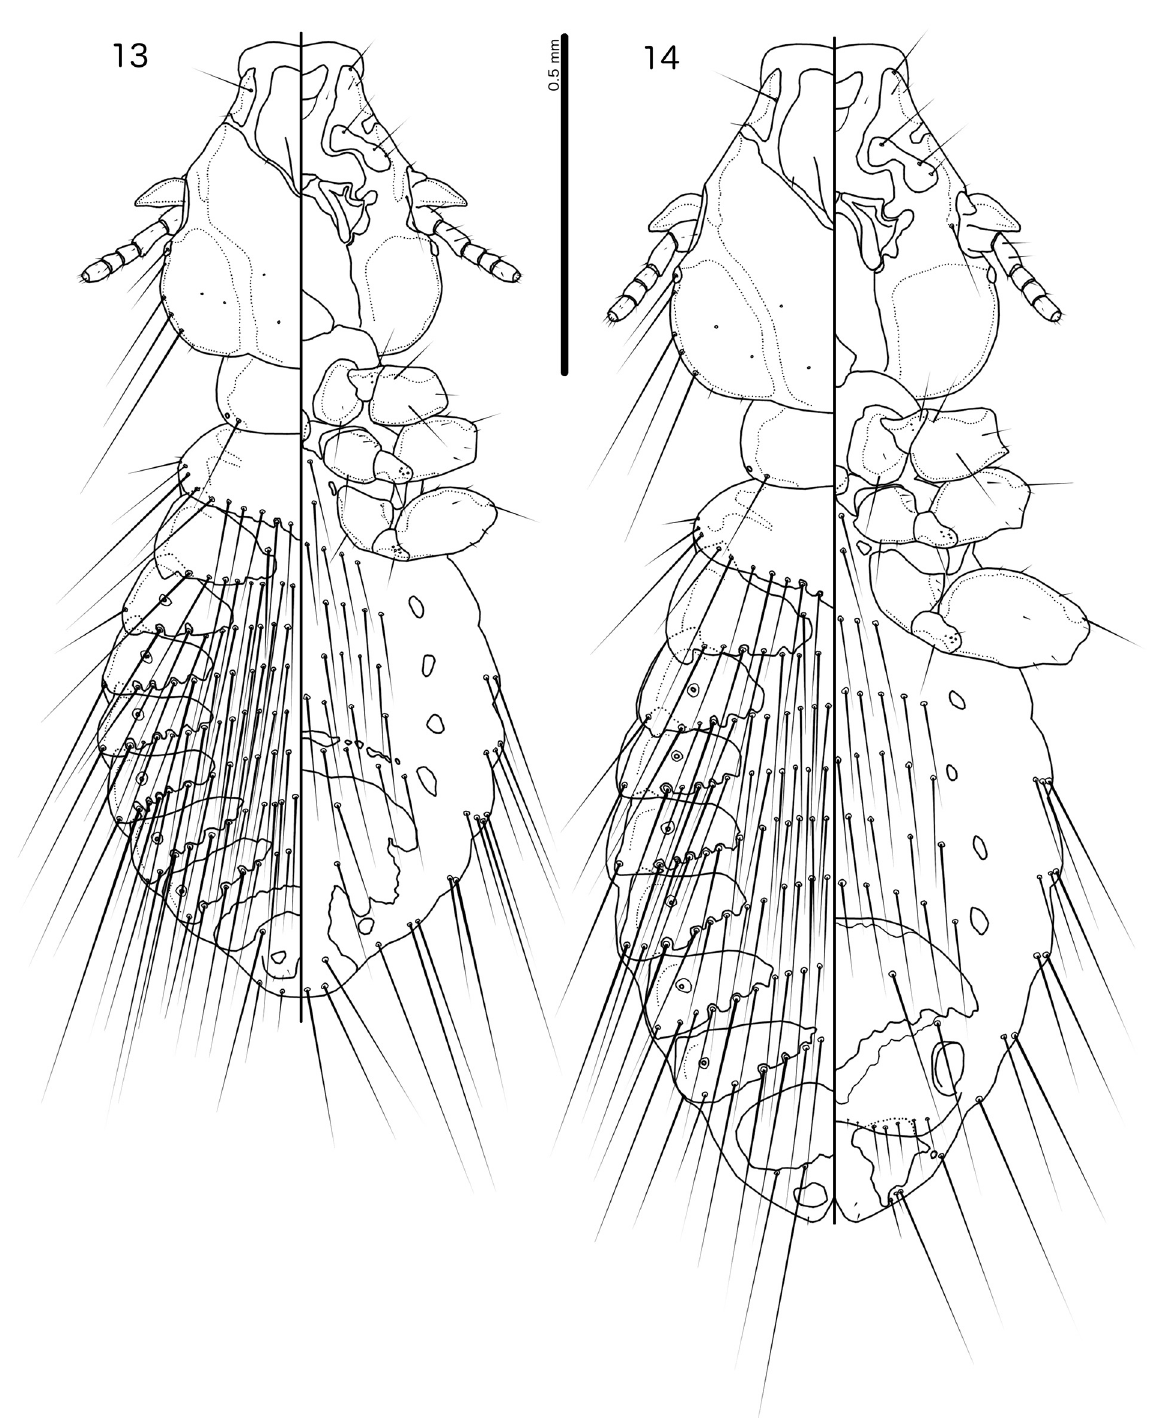
Figs 13–14. Philopterus afropari sp. nov. ex Melaniparus cinerascens cinerascens (Vieillot, 1818). 13 . Male habitus, dorsal and ventral views. 14 . Female habitus, dorsal and ventral